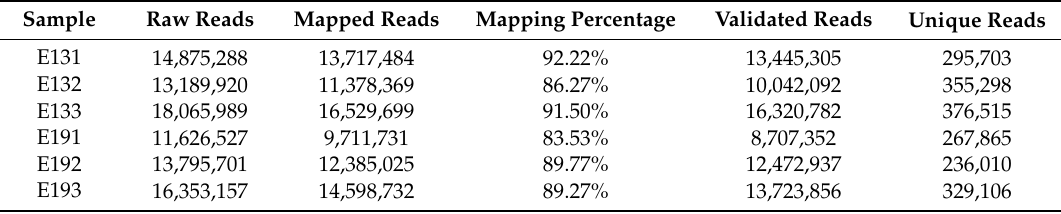
Table 1. Summary of microRNA (miRNA) sequencing